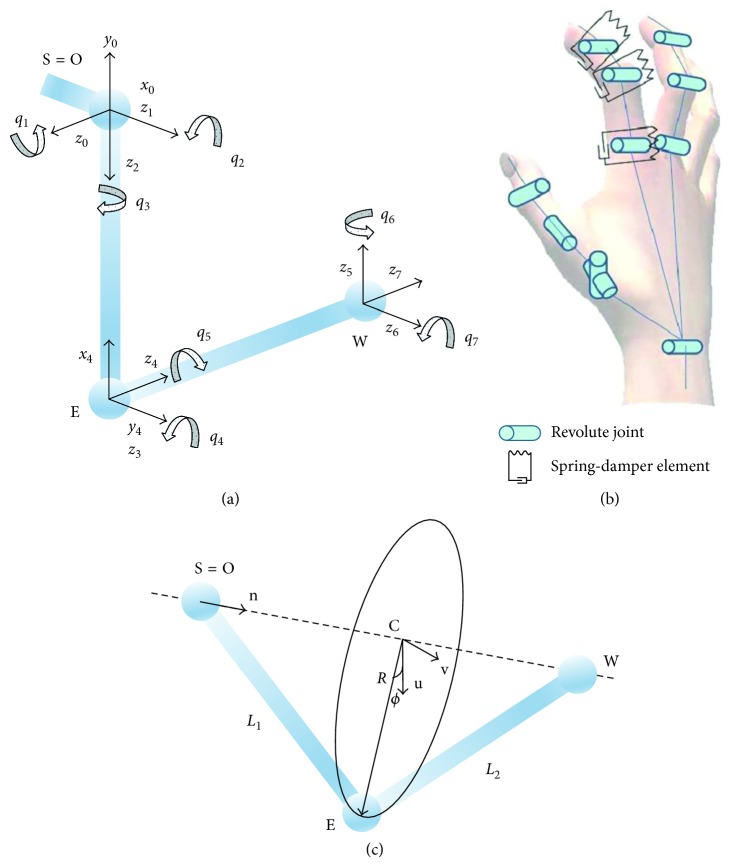
A simulation model of the upper limb. (a) 7-DoF kinematic model of the arm. (b) 17-DoF kinematic model of the hand, with the physical interpretation as a multirigid body system with spring-damper joints. (c) Elbow position as a function of the swivel angle ϕ.